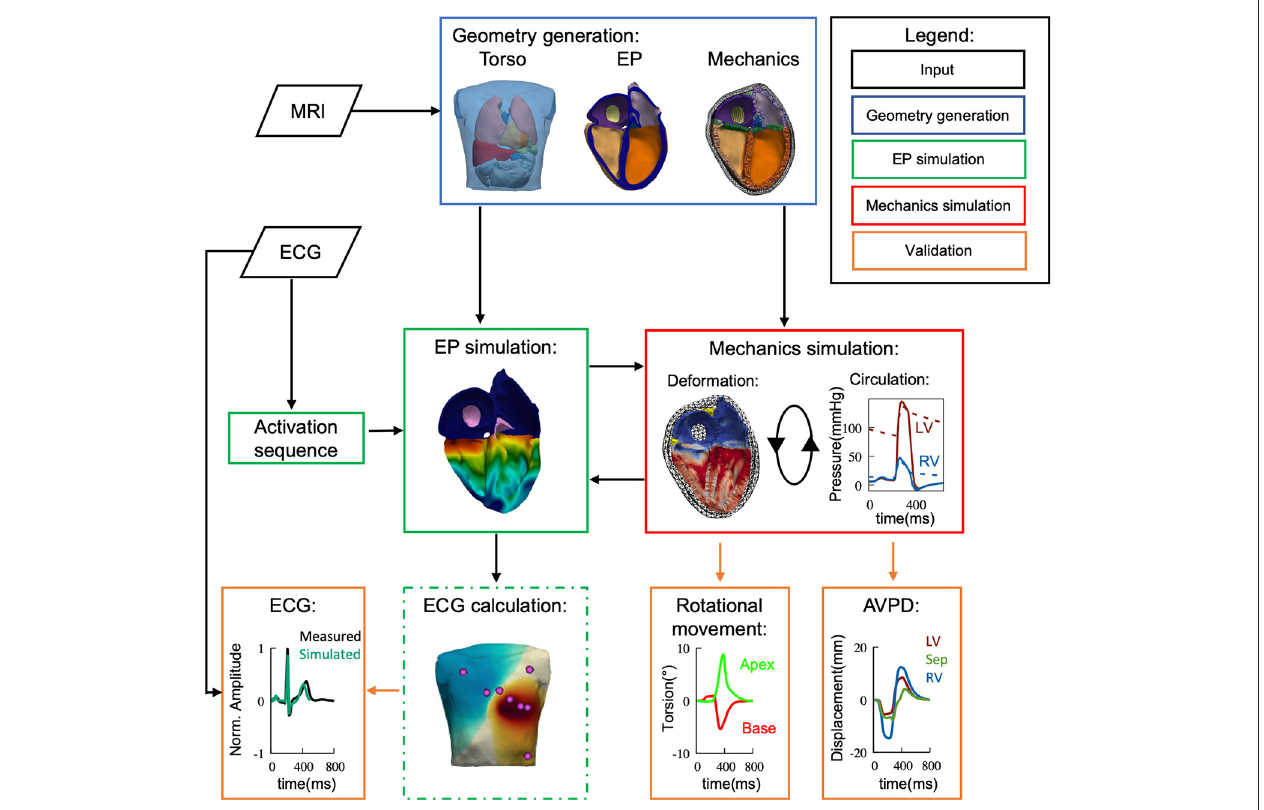
FIGURE 1 | Flow diagram depicting the used methods of simulation and validation within this study. Based on measured data (black) we have developed a 4-chamber fully coupled electro-mechanical (green/red) computational model, embedded within the torso. MRI and ECG were recorded from the same volunteer. The electrophysiological side of the model was then validated against the ECG data and the mechanical side against literature values in terms of cardiac output, valve plane movement and ventricular rotational movement.